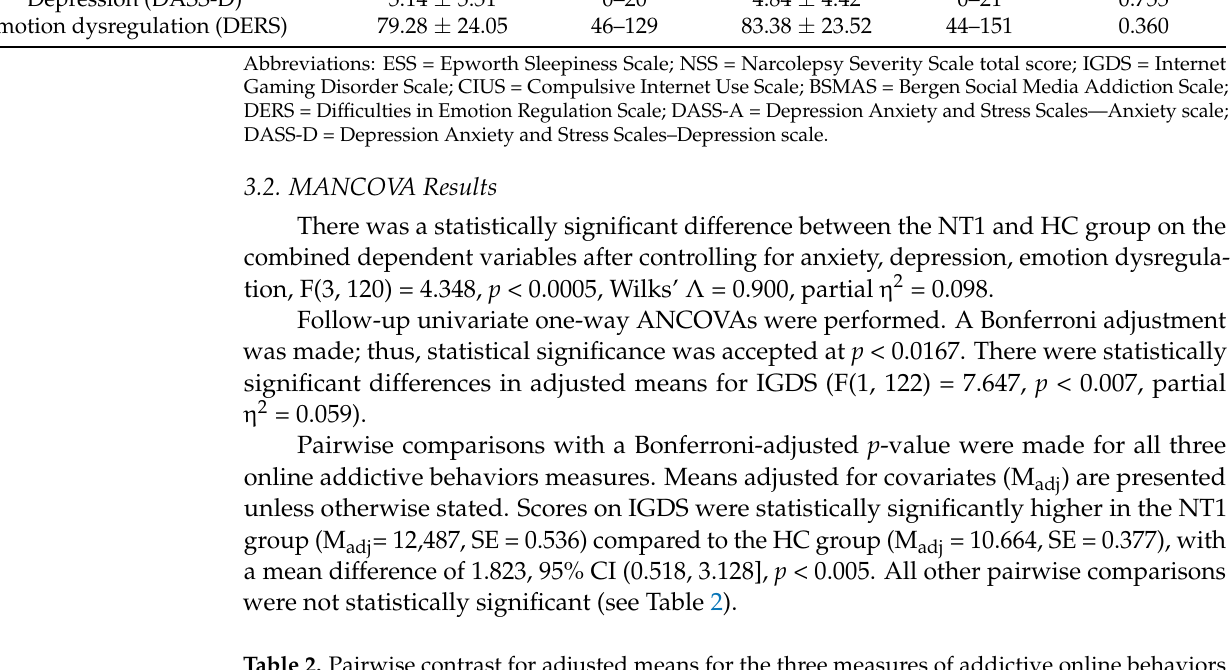
Table 2. Pairwise contrast for adjusted means for the three measures of addictive online behaviors for NT1 and HC